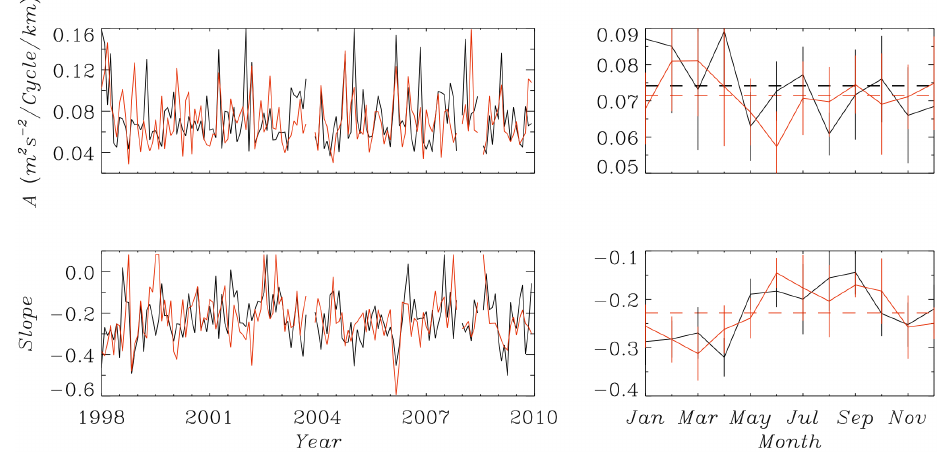
Figure 7. Same as for Fig. 6, but in the lower